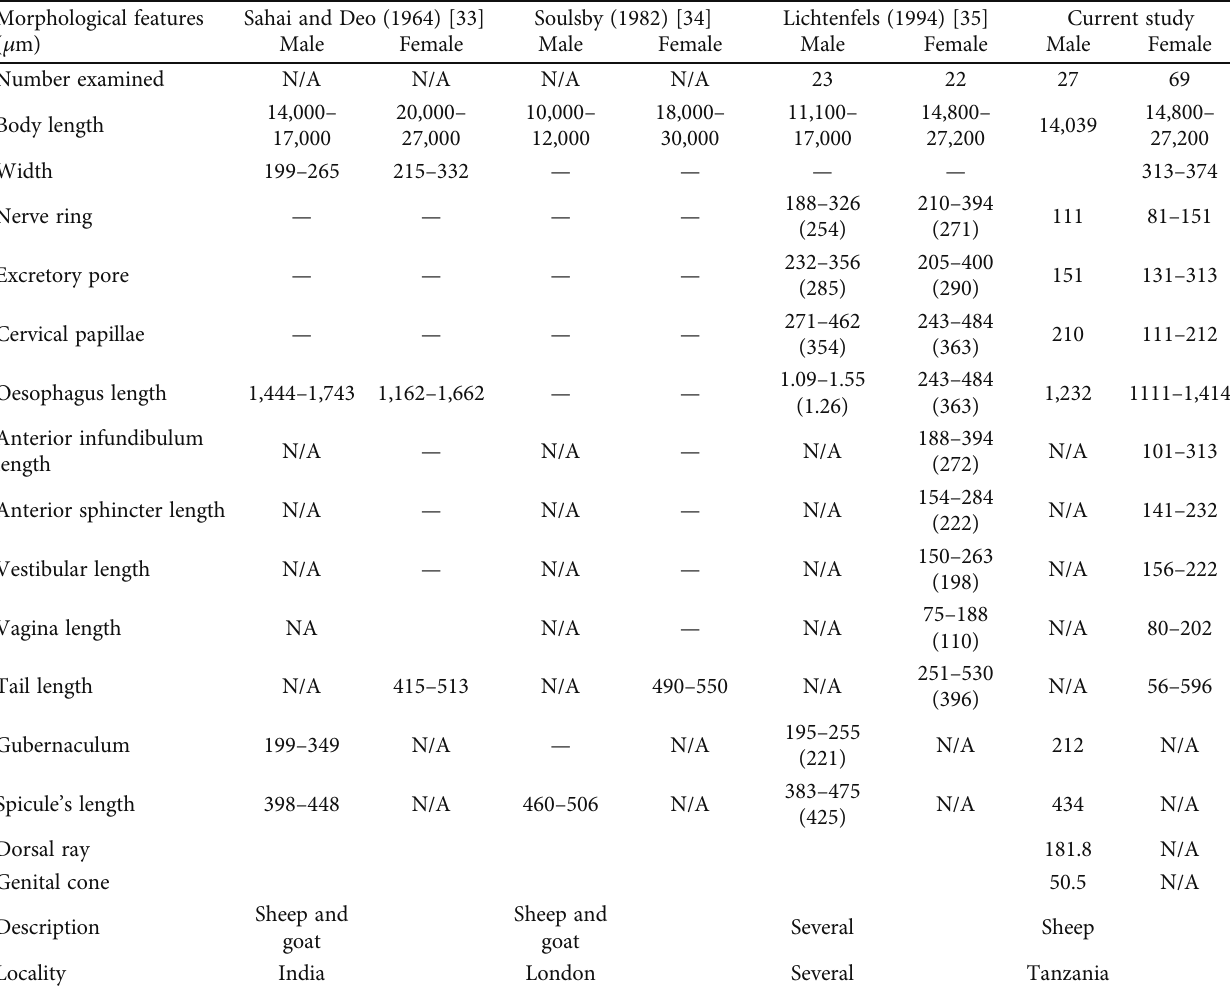
Table 1: Morphometric features of male and female Haemonchus contortus collected in Tanzania compared with other locations. Morphological